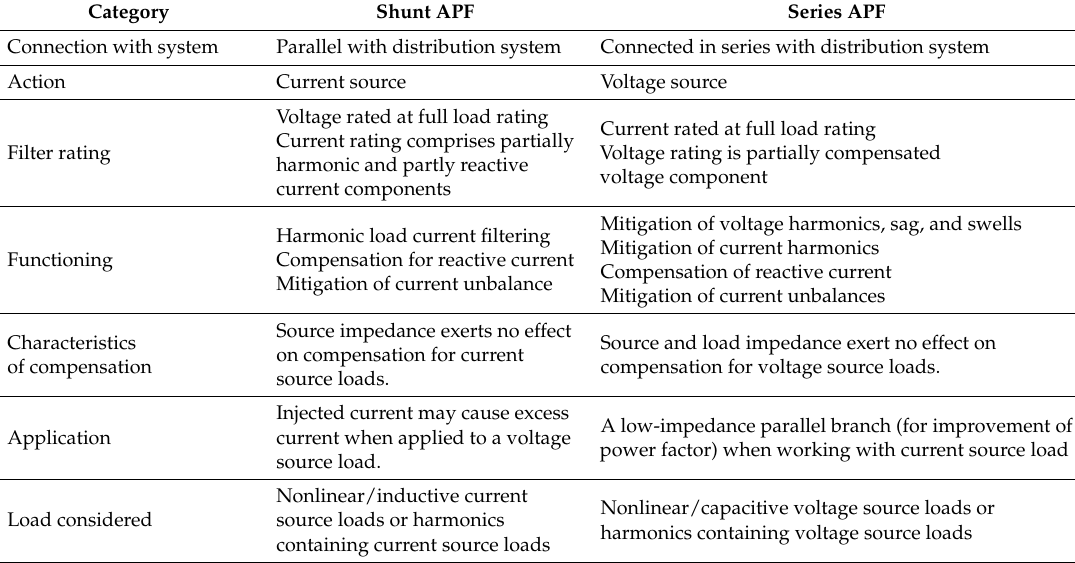
Table 1. Comparison of active power filters (APFs) in power quality improvement